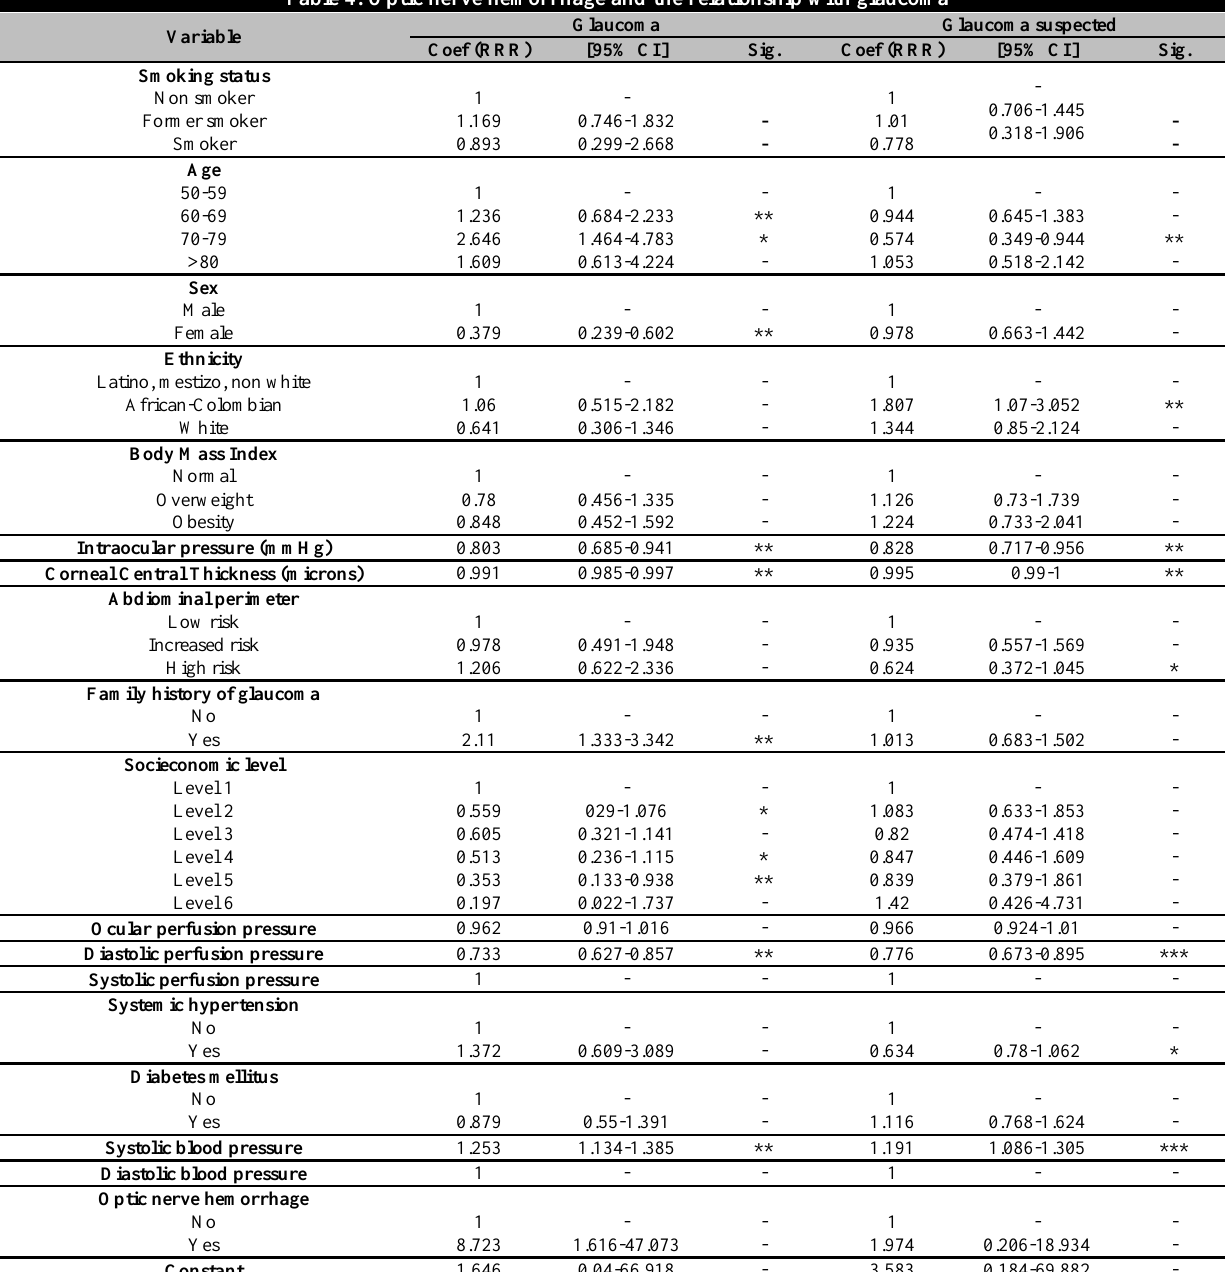
Table 4: Optic nerve hemorrhage and the relationship with